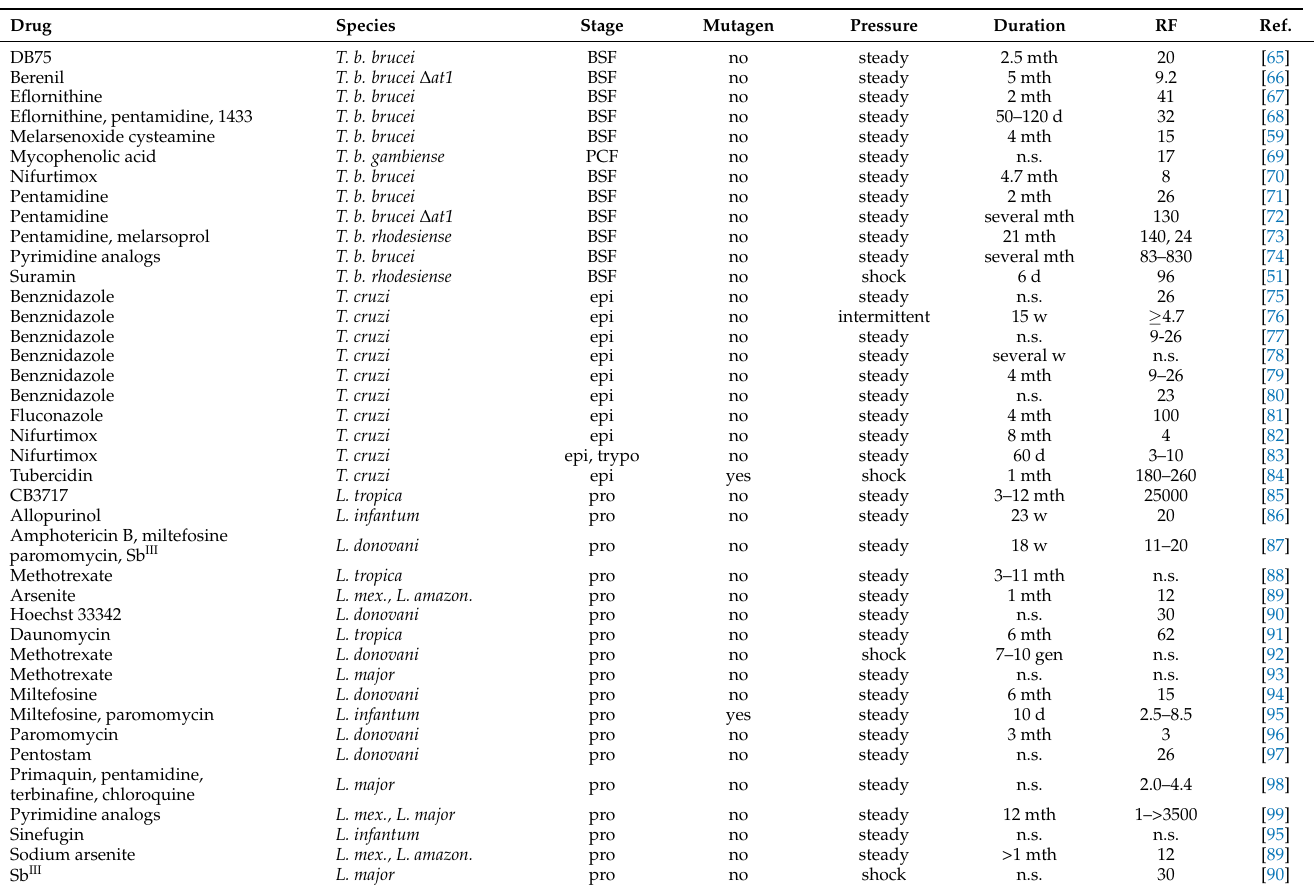
Table 3. Reports of successful in vitro selection of trypanosomatids for drug resistance (BSF, blood- stream form; PCF, procyclic form; epi, epimastigotes; pro, promastigotes; trypo, trypomastigotes; RF, resistance factor; n.s., not